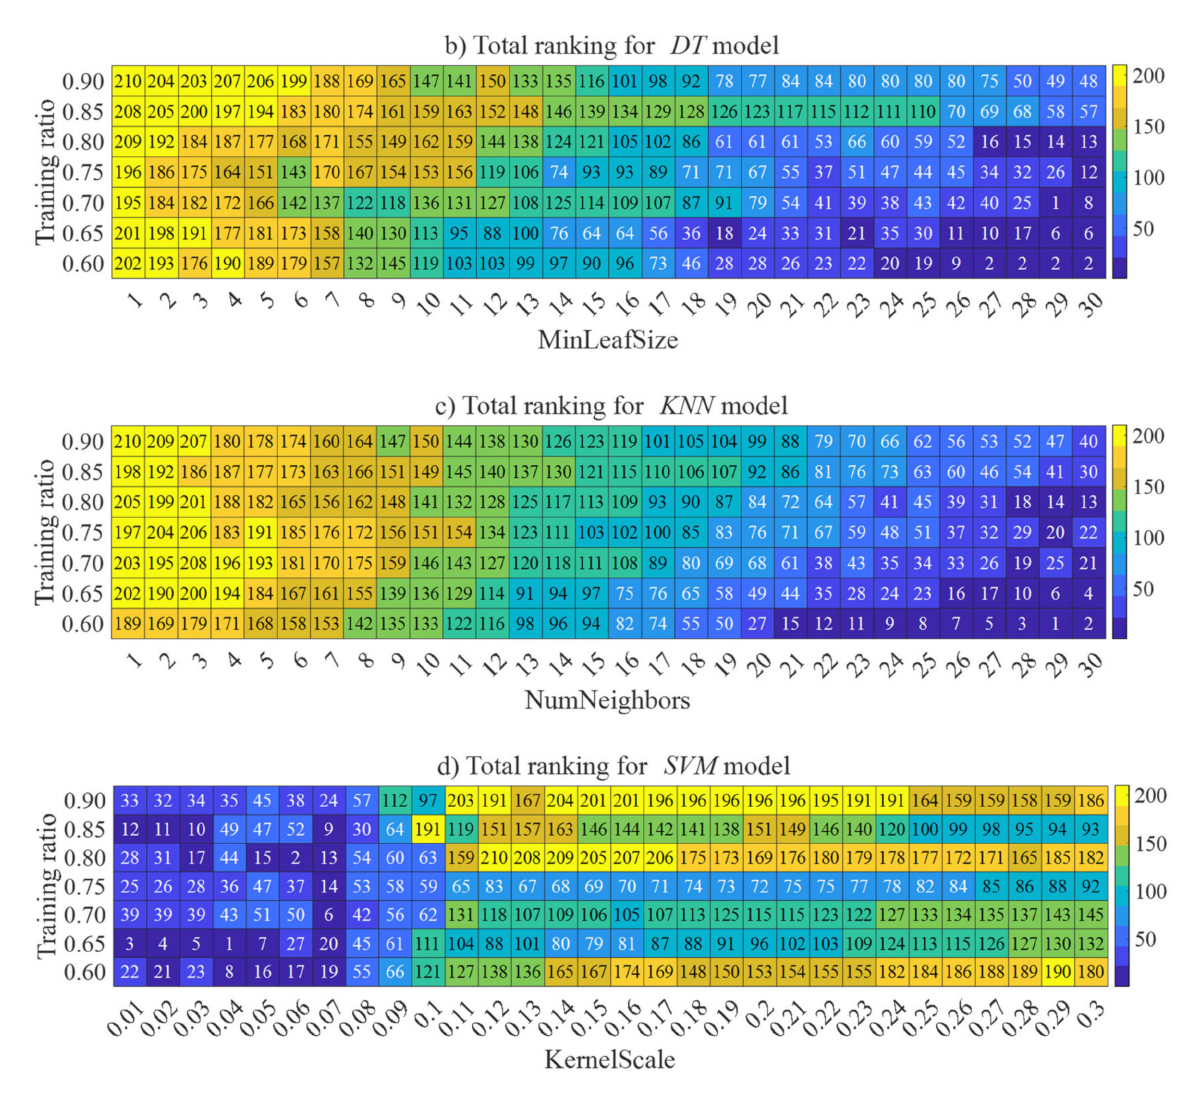
Figure 17. The ranking of 210 cases in each ML model for classifying failure modes.